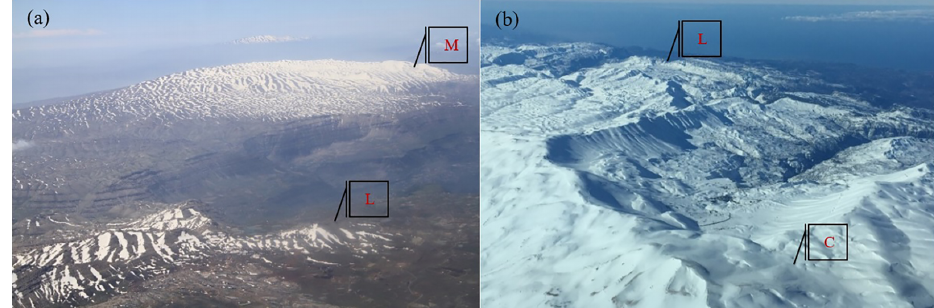
Figure 2. Overview of the mountain topography at (a) Laqlouq and Mzar and (b) Cedars, Mount Lebanon. The images were captured on 6 May 2011 (a) and 21 February 2015 (b) (courtesy of the author). The locations of the AWSs are shown approximately on the images where the letters M, L, and C represent the stations at MZA, LAQ, and CED, respectively (see Table 1). The topography near Laqlouq (LAQ) is a relatively low plain (elevation between 1600 and 1800ma.s.l.) and low-elevation mountains (1900–2100ma.s.l.). The region near Mzar (MZA) is characterized by rugged terrain (1600–2200ma.s.l.) and mid-elevation plateau (elevation range 2300–2500m). The high-elevation plateau (shown partially in panel b near Cedars, CED) have an elevation range between 2700 and 3000ma.s.l. Snow persists until the end of May in the mid-elevation mountain regions (plateau and rugged terrain region above 2300ma.s.l.). The low-elevation and mid-elevation regions (1300–2000ma.s.l.) are usually snow-free by mid-March to mid-April. Table 1. Attributes of the three snow-dominated basins in Mount Lebanon described in this study. Basin a Area elevation range Dominant land AWS Elevation, Snow course count (km 2 ) (average) b , cover c